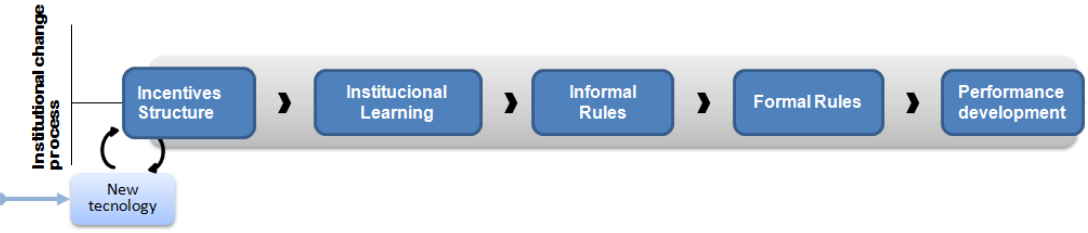
Figure 1. Institutional change process. Source: the authors.